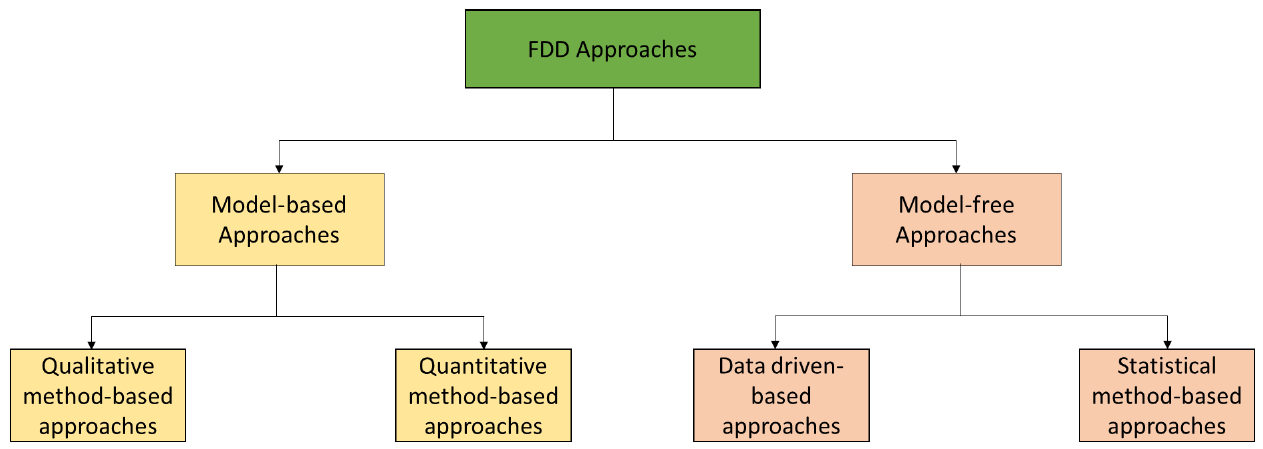
Figure 4. Diagram of Various Fault Detection Techniques in Power Plant Systems.